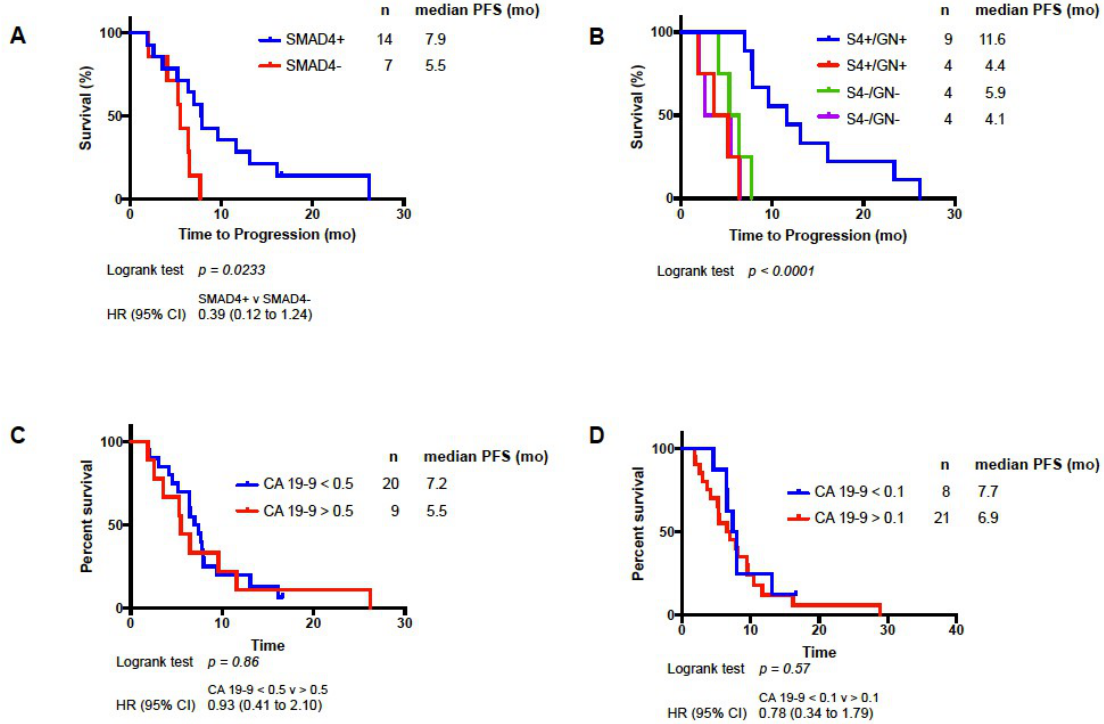
Figure 3. Kaplan–Meier analysis of PFS based on ∆ SMAD4 ( A ), ∆ SMAD4 (S4), and G/nab-P sensitivity (GN+) or resistance (GN-); ( B ) decrease in carbohydrate antigen (CA) 19-9 by 50% ( C ) or 90% ( D ) after 2 months of treatment with G/nab-P.